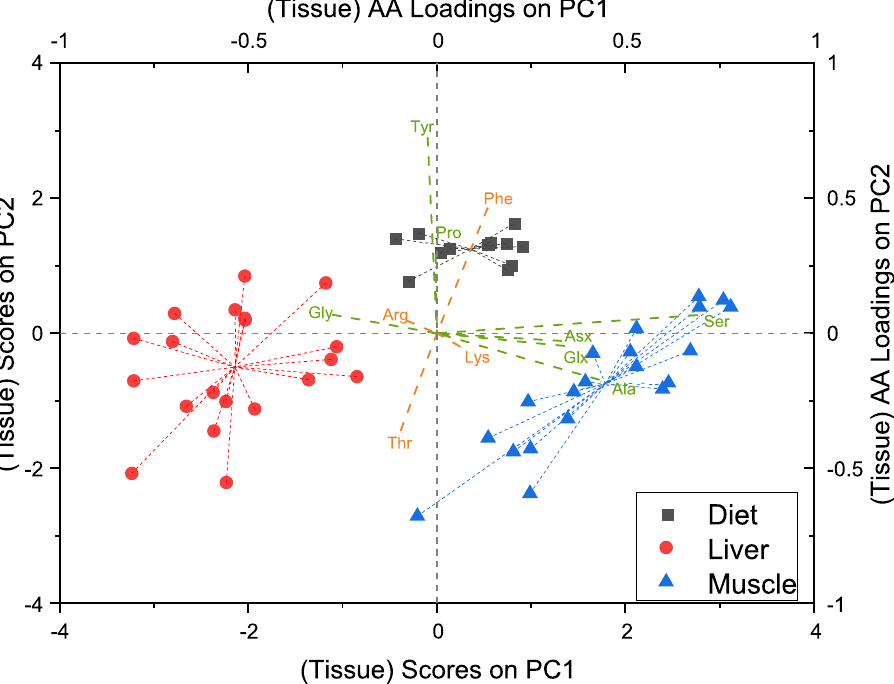
Figure 2. Multivariate analysis of δ 13 C values shows distinct δ 13 C patterns of NEAAs in liver samples compared to dietary and muscle samples. Biplot of sample scores from ASCA for factor 1 (tissue) separates between liver ( ) and muscle ( ) or dietary ( ) samples on PC1. Scores of liver samples on PC1 are negative in contrast to positive scores of muscle samples or scores around 0 for dietary samples. NEAA loadings ( ) on PC1 are positive for Ala, Ser, Asx and Glx and negative for Gly, whereas EAAs ( ) and Pro have no impact on PC1. AA loadings on PC2 are positive for Pro, Phe and Tyr and negative for